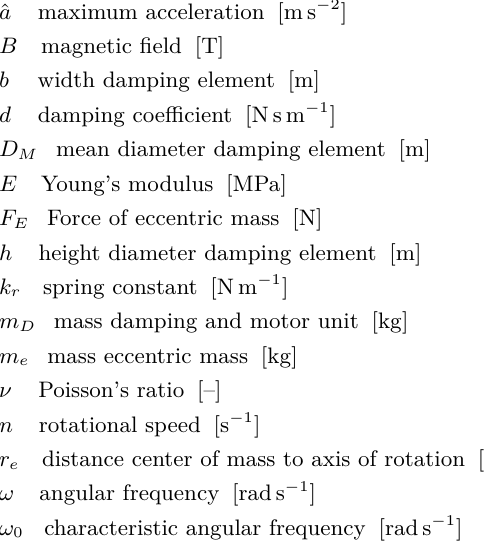
Figure 8. Results - iron particle filled silicone